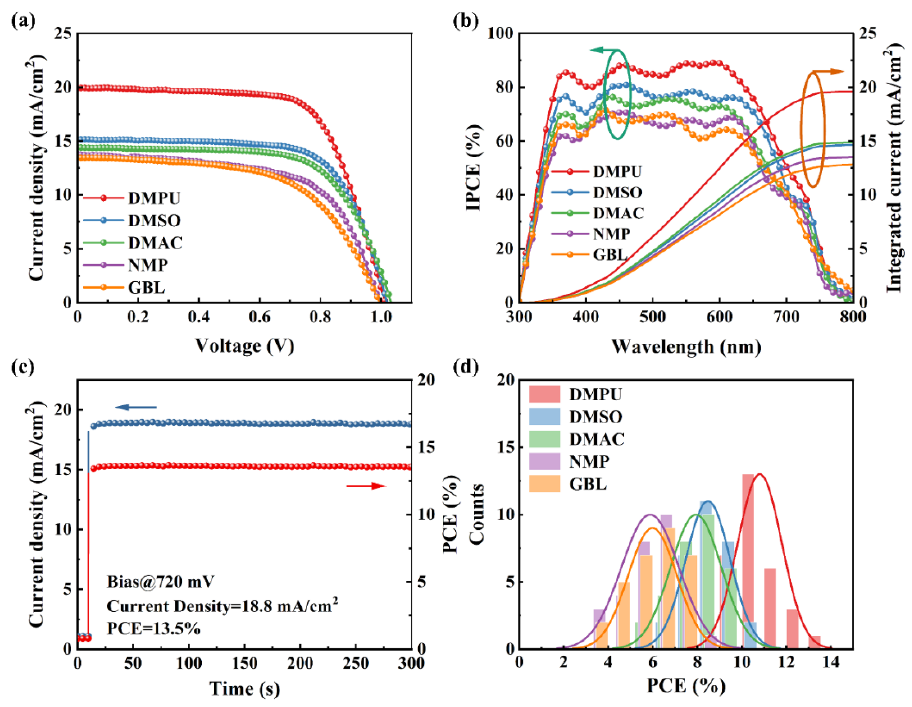
Figure 2. ( a ) J-V curves and ( b ) IPCE of devices prepared with different solvents. ( c ) the stabilized photocurrent measurement and power output of devices prepared by DMPU, under simulated AM 1.5 G illumination of 100 mW/cm 2 . ( d ) Histogram of PCEs of devices prepared with different solvents. Table 1. Photovoltaic parameters of solar cells based on perovskite films prepared with different solvents. V oc (V) J sc (mA/cm 2 ) FF PCE (%) best 1.01 DMPU Best DMPU DMAC best 1.02 DMAC average 0.97 ± 0.06